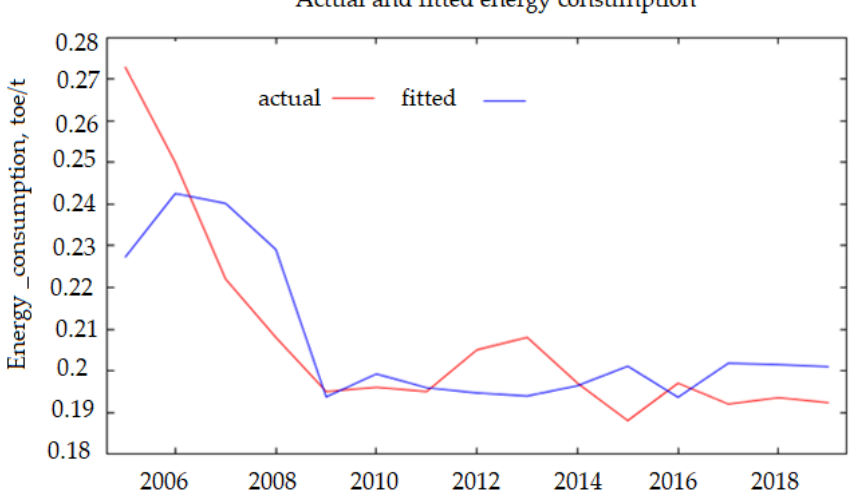
Figure 10. Theoretical (fitted) and empirical (actual) values of energy consumption in the examined time period.